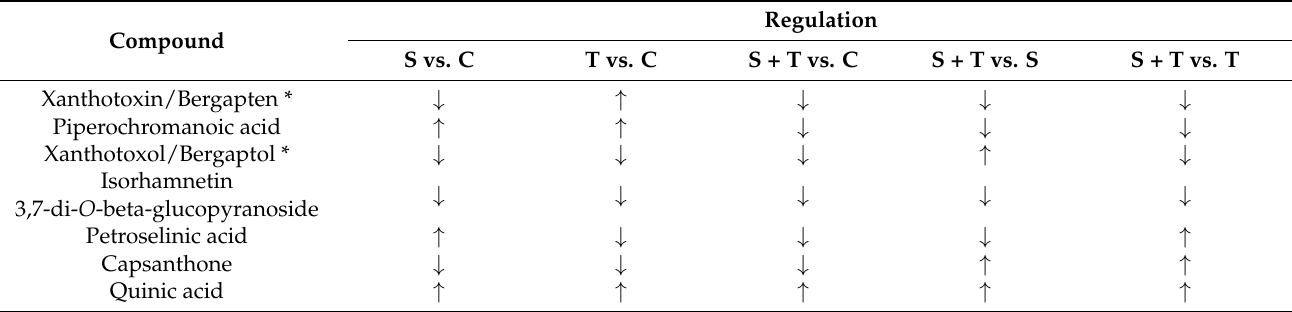
Table 2. Putatively identified metabolites that are differentially accumulated in plants treated with Streptomyces (S), Trichoderma (T) or a mix of those two (S + T) compared to control group (C) plants and the microbial consortium (S + T) compared to Streptomyces (S) and Trichoderma (T) single culture. Compound * Stereoisomers for which it was not possible to make a distinction in the chromatogram. ↑ Upregulated against C, S or T group. ↓ Downregulated against C, S or T group.